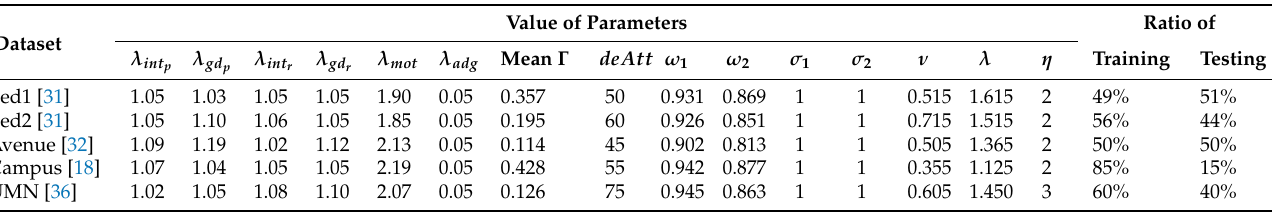
Figure 16. A sample output using S.T.-Campus [18], where a bicycle anomaly was happened. ( a , b ) exhibit PSNR scores, whereas ( c , d ) show frame-level scores. Table 4. List of parameters and their used